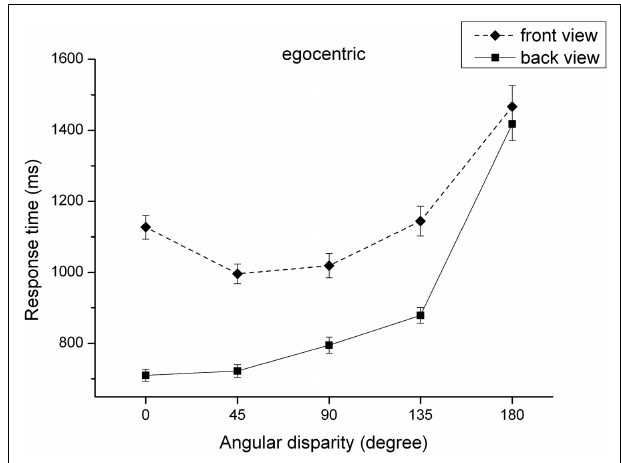
FIGURE 6 | Reaction time (mean and SE) dependent on view and angular disparity for egocentric transformations.